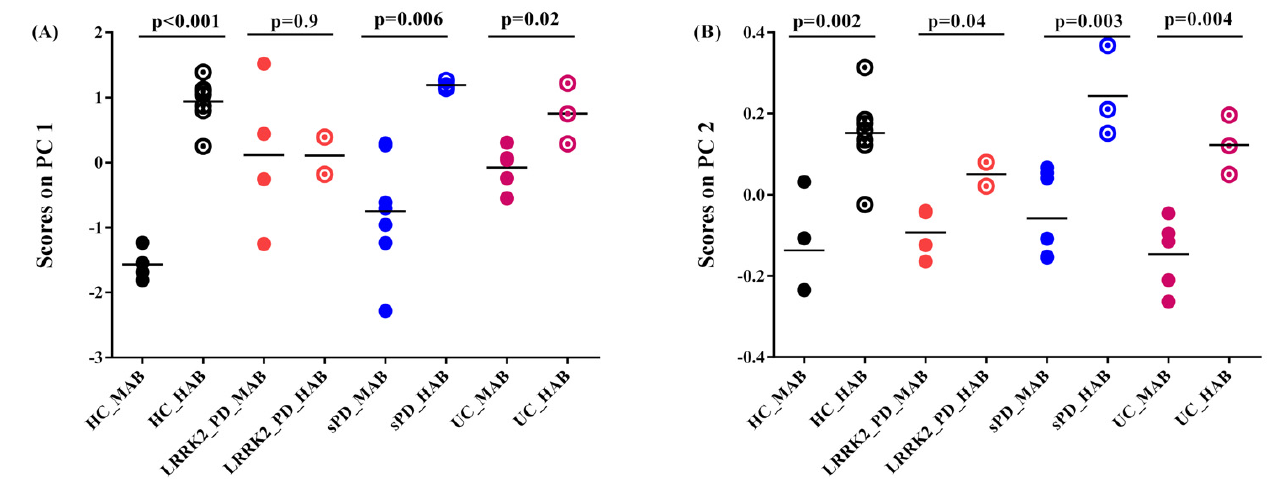
Figure 5. Graphs of scores on principal components. ( A ) Scores on PC1 of absolute SUV PCA decomposition. Healthy control with high-affinity binder (HC-HAB) group was significantly higher than the healthy control with mixed affinity binder (HC-MAB). Sporadic Parkinson’s disease with high-affinity binder (sPD-HAB) has a distinct trend increase toward significance compared to sporadic Parkinson’s disease with mixed affinity binder (sPD-MAB) group. lrrk2 Parkinson’s disease with high-affinity binder (lrrk2-PD-HAB) has similar scores as for Lrrk2 Parkinson’s disease with mixed affinity binder (Lrrk2-PD-MAB). Unaffected Lrkk2 mutation carriers with high-affinity binder (lrrk2- UC-HAB) group was significantly higher than unaffected Lrrk2 mutation carriers with mixed affinity binder (lrrk2-UC-MAB) group. ( B ) Scores on PC2 of PCA decomposition of SRP SUV. HC-, PD- and lrrk2-UC-HAB groups were significantly higher than HC-, sPD-, Lrrk2-PD- and lrrk2-UC-MAB matched